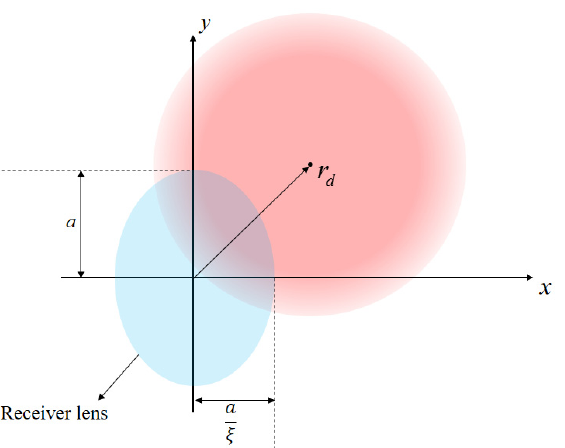
Figure 3. Geometry and pointing error diagram of the UAV optical communication in the flight state.